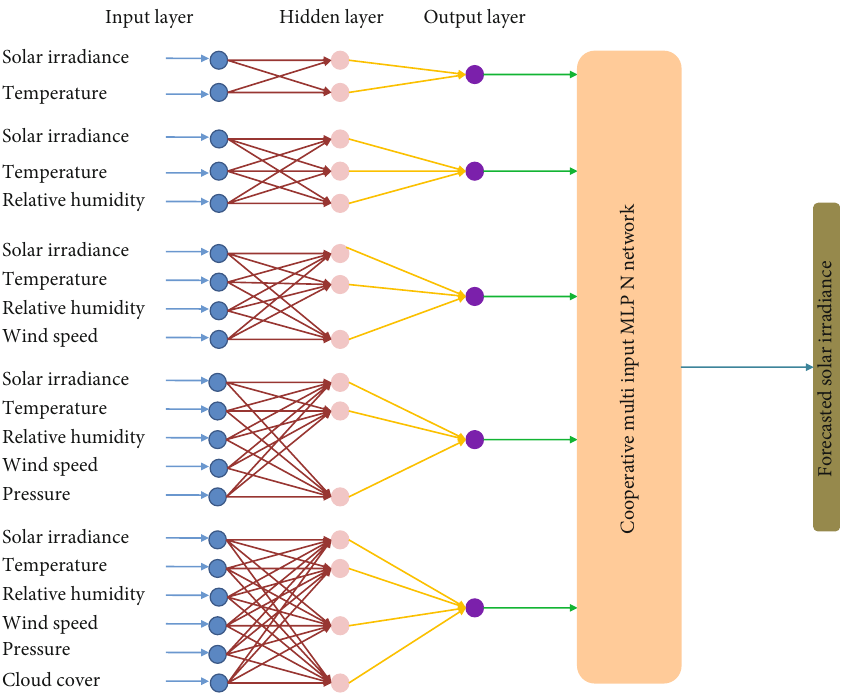
Figure 1: The framework of the proposed cooperative multi-input multilayer perceptron neural